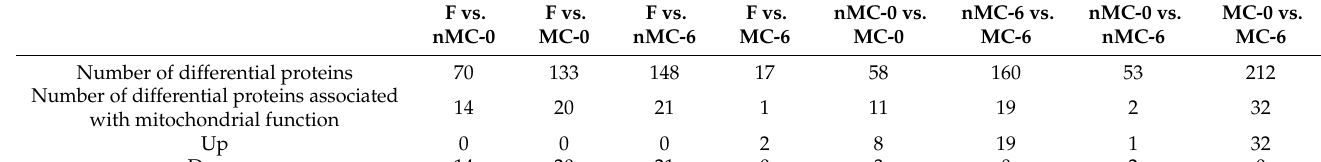
Table 2. Statistical table of the number of differential proteins related to mitochondrial function in each group.